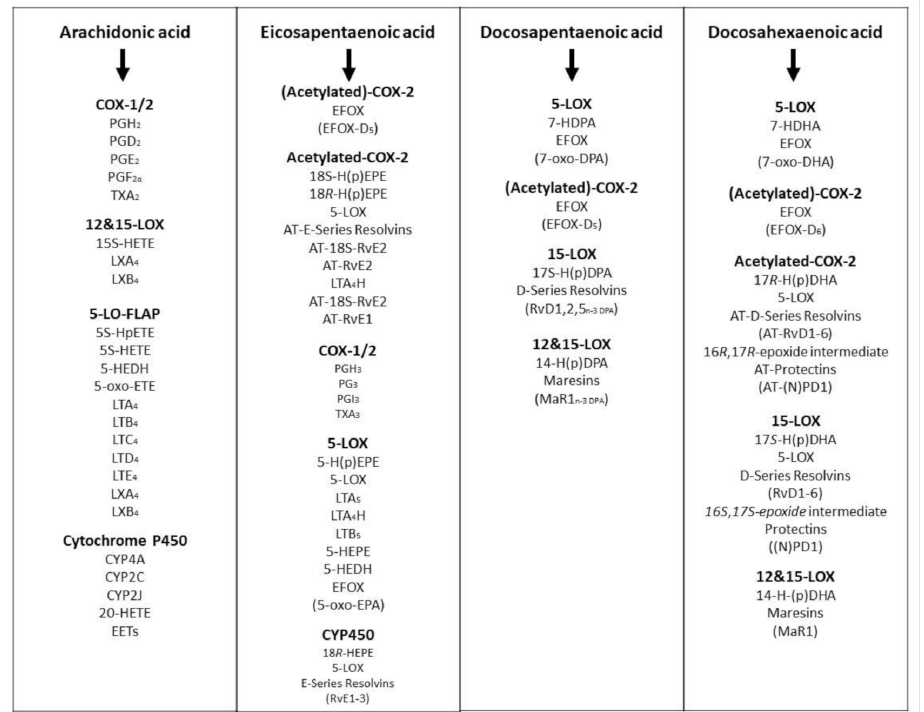
Figure 5. The formation of lipid mediators (intermediary metabolites and isoforms) from eicosanoids and docosanoids derived from long chain omega-3 (EPA, DPA, DHA) and omega-6 (AA) fatty acids in animals and human tissues or